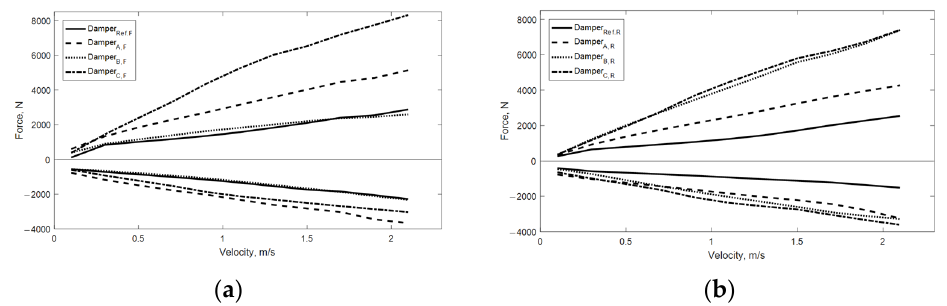
Figure 7. Damper characteristics test results: (a) Front damper characteristics; ( b ) Rear damper characteristics.